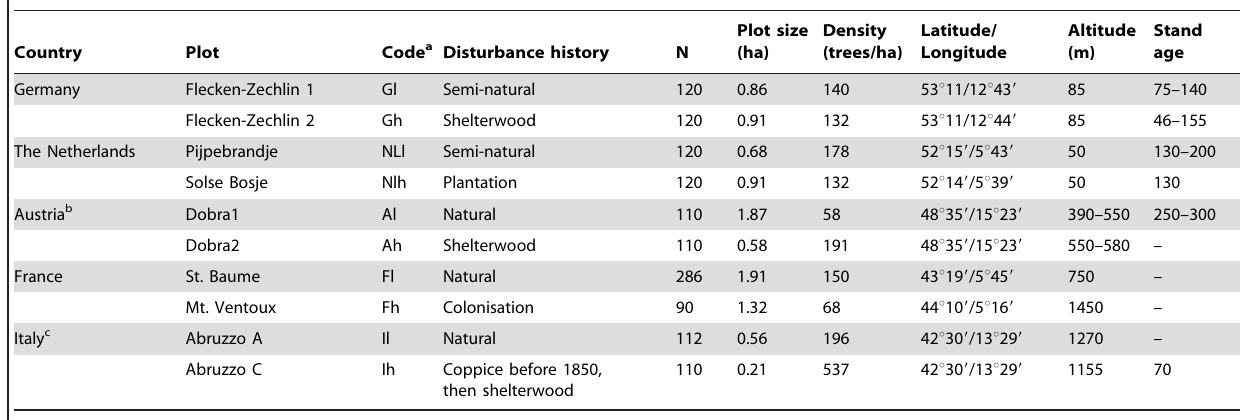
Table 1. Characteristics of investigated beech